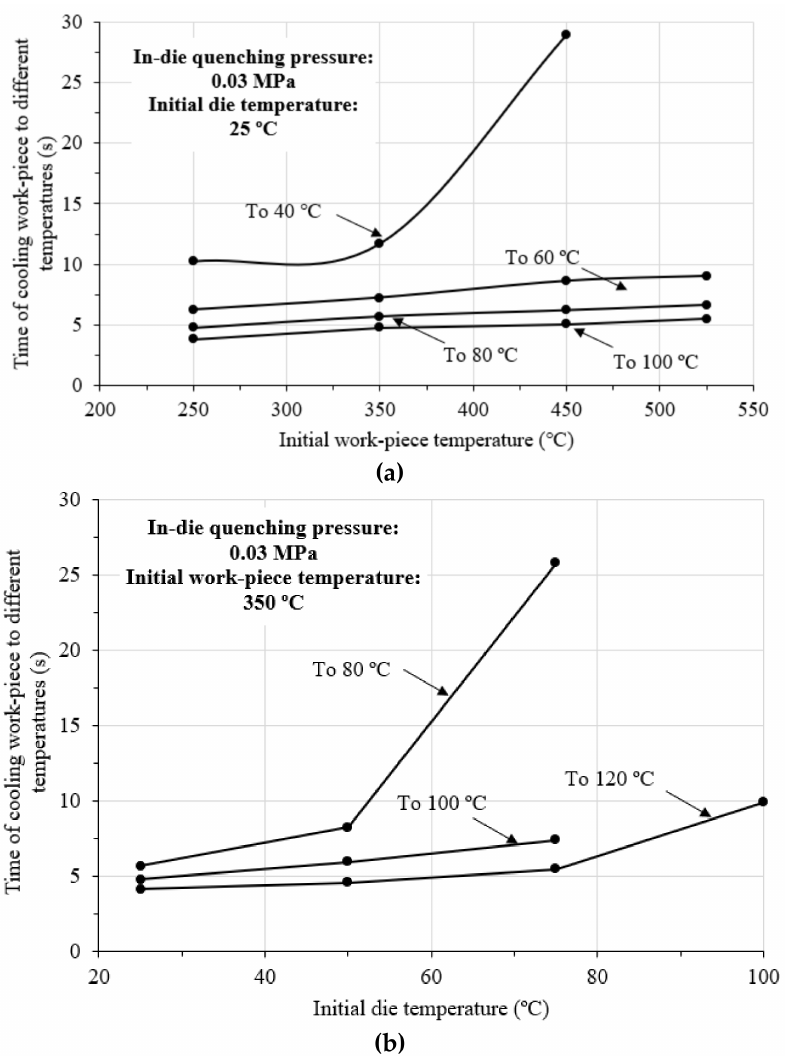
Figure 6. Effects of initial blank and die temperatures on the in-die quenching time of cooling work-piece to different temperatures at an in-die quenching pressure 0.03 MPa. The work-piece thickness was 2 mm. ( a ) Different initial work-piece temperatures; and ( b ) different initial die